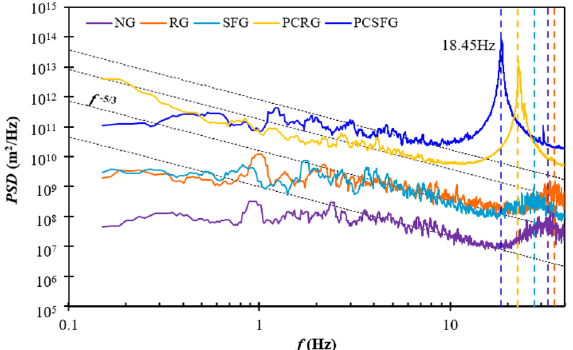
Figure 9. The 10-lapse period moving averaged PSD of velocity fluctuation induced with various grids at Re Dh = 22.0 ×